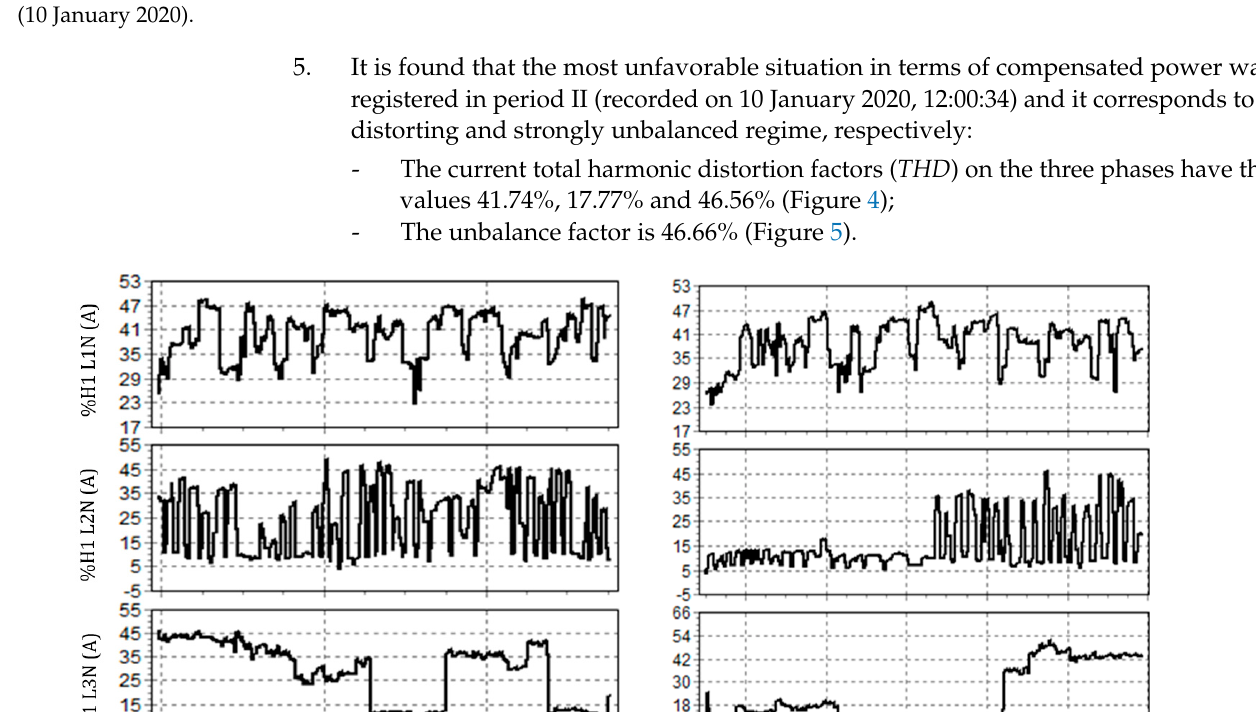
Figure 3. The power factor for each phase: ( a ) during the first period (9 January 2020); ( b ) during the second period (10 January 2020).